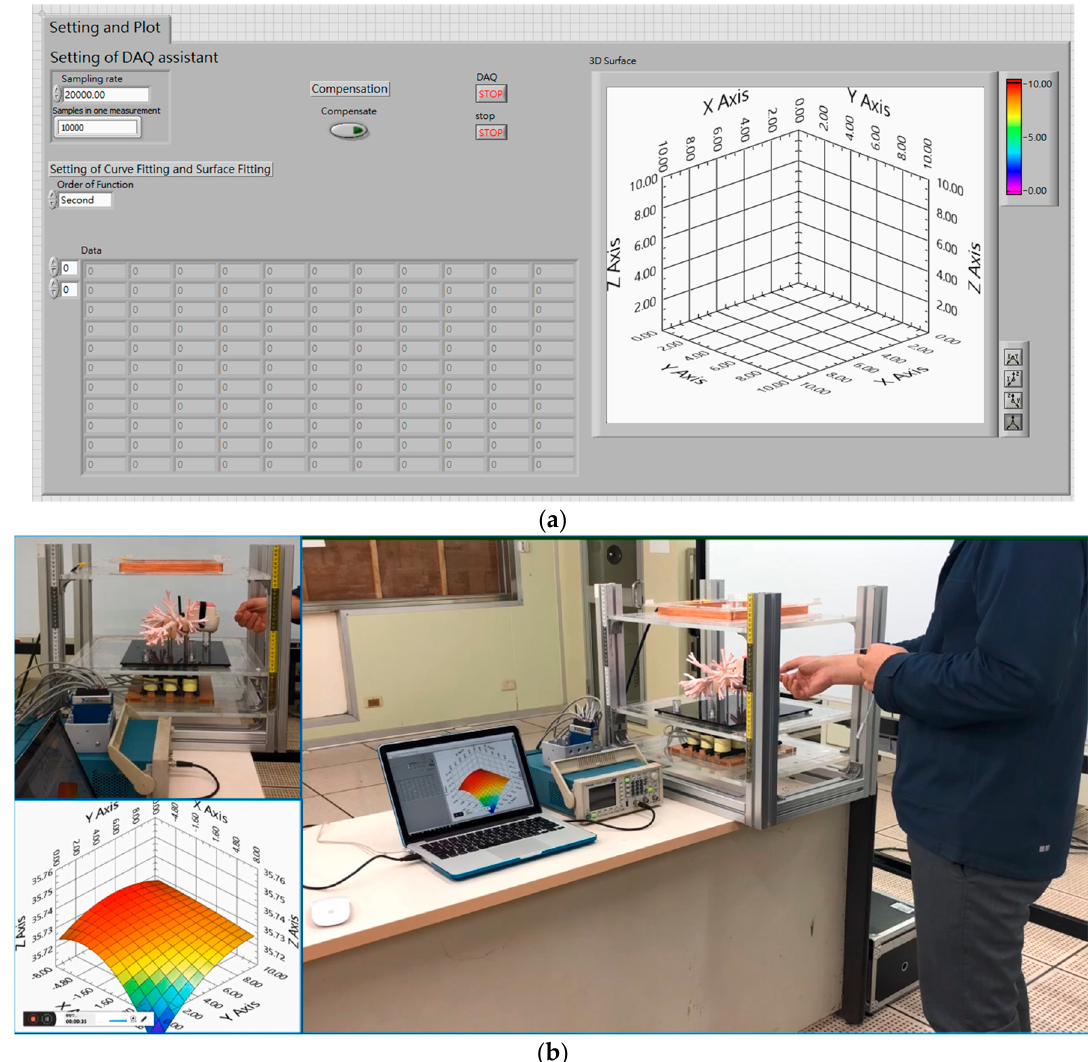
Figure 10. Demonstration of using the user–interface program in a targeting test: ( a ) program overview, ( b ) video-demonstration of using the program in a real-time targeting test (note: the program is developed by using the Labview program).